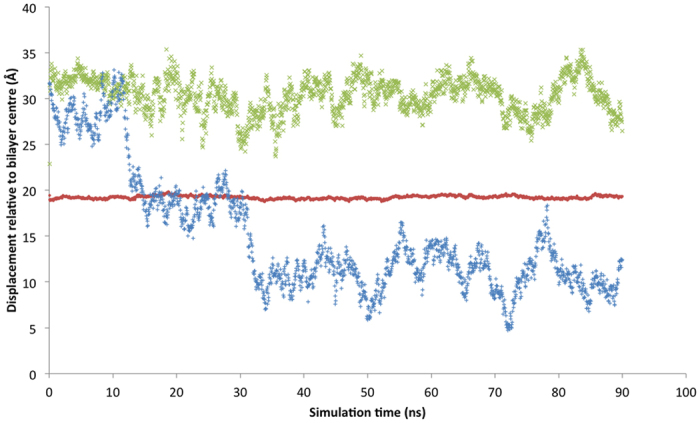
Example Z-direction displacement of centre of mass of (i) bilayer phosphates (red), (ii) nisin1 N-termini heavy atoms (green) and (iii) nisin2 N-termini heavy atoms (blue) for a trajectory run where nisin2 inserts into bilayer.